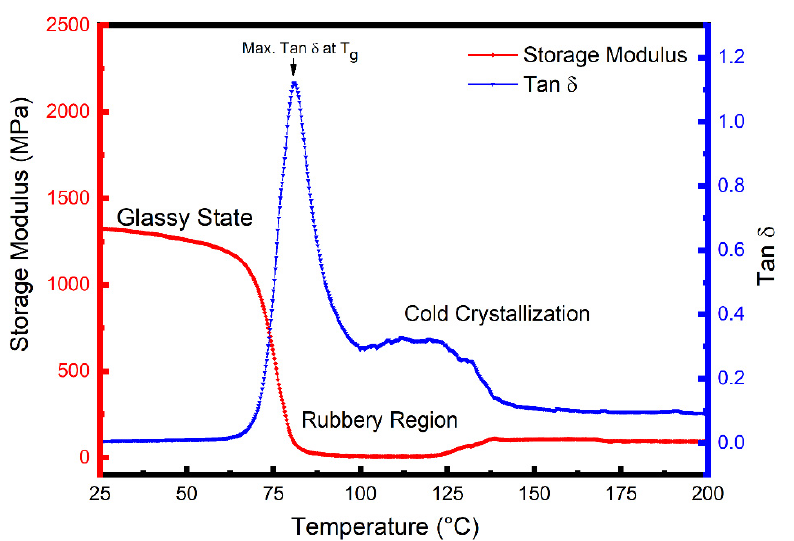
Figure 2. Dynamic mechanical thermal analysis (DMTA) curves of storage moulus, E ′ , and loss tangent, tan δ , as a function of temperature for the PET matrix.